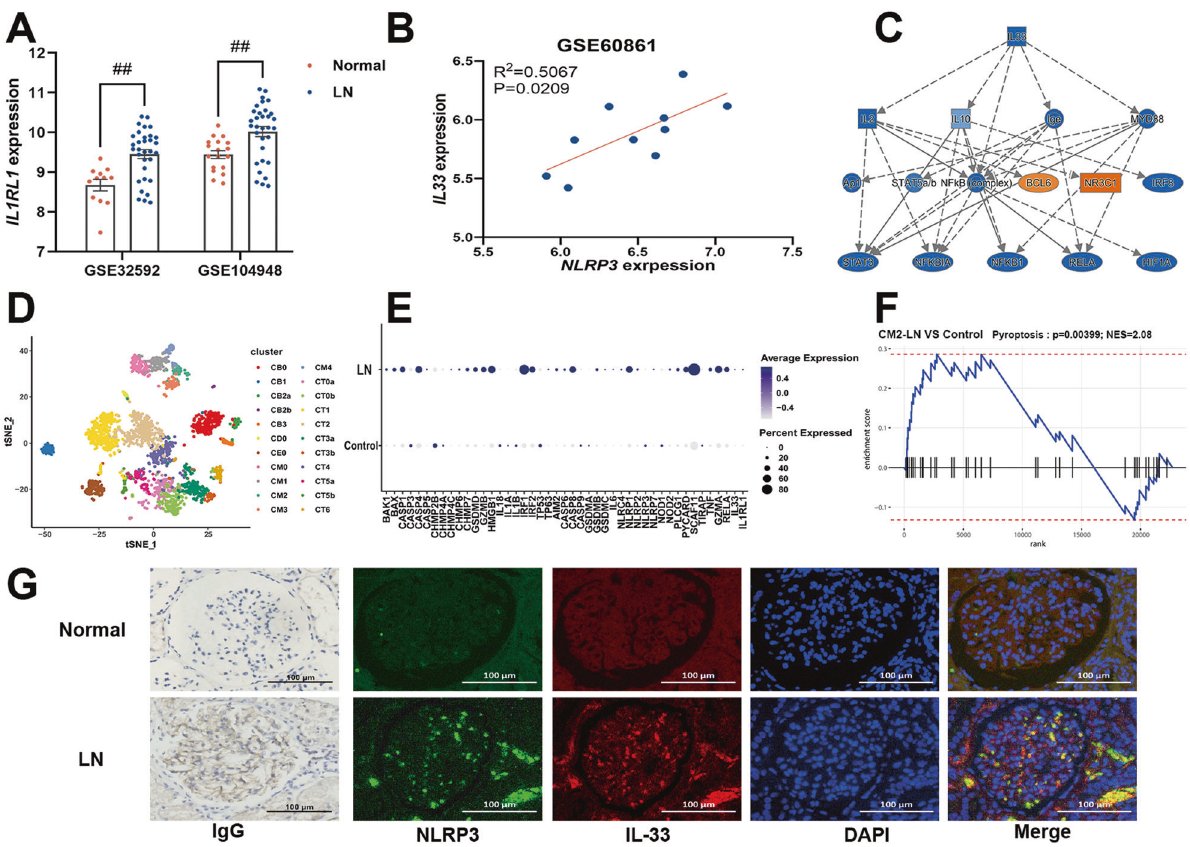
Fig. 3 Bioinformatics analysis showed that the IL-33/ST2 and NLRP3 pathways were activated in LN. A IL1RL1 was signi fi cantly upregulated in patients with lupus nephritis (LN). B A signi fi cant positive correlation between NLRP3 and IL33 was observed in patients with LN. C The factors downstream of IL-33 in the pathway activated by Honokiol, as predicted using ingenuity pathway analysis. D Clustering diagram showing the spatial dimensionality reduction of the single-cell data. E Bubble chart showing the pyroptosis-related genes, NF- κ B, IL-33, and IL1RL1. F Gene set enrichment analysis of the single-cell pyroptosis pathway. G Immunohistochemical assessment of the IgG levels in the healthy and LN kidney samples and immuno fl uorescence staining of NLRP3 and IL-33. 200×; scale, 100 μ